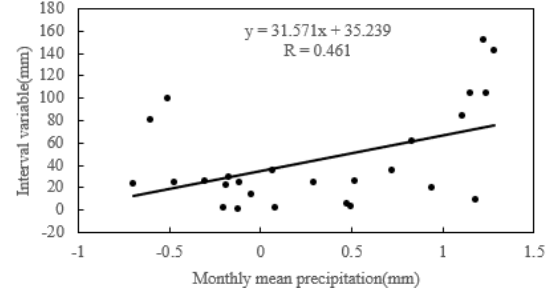
Figure 8. The relationship between interval variables